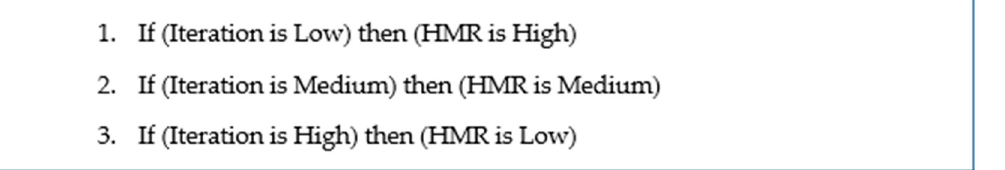
Figure 9. Rules for Fuzzy System 1 to Decrease (FHS1).